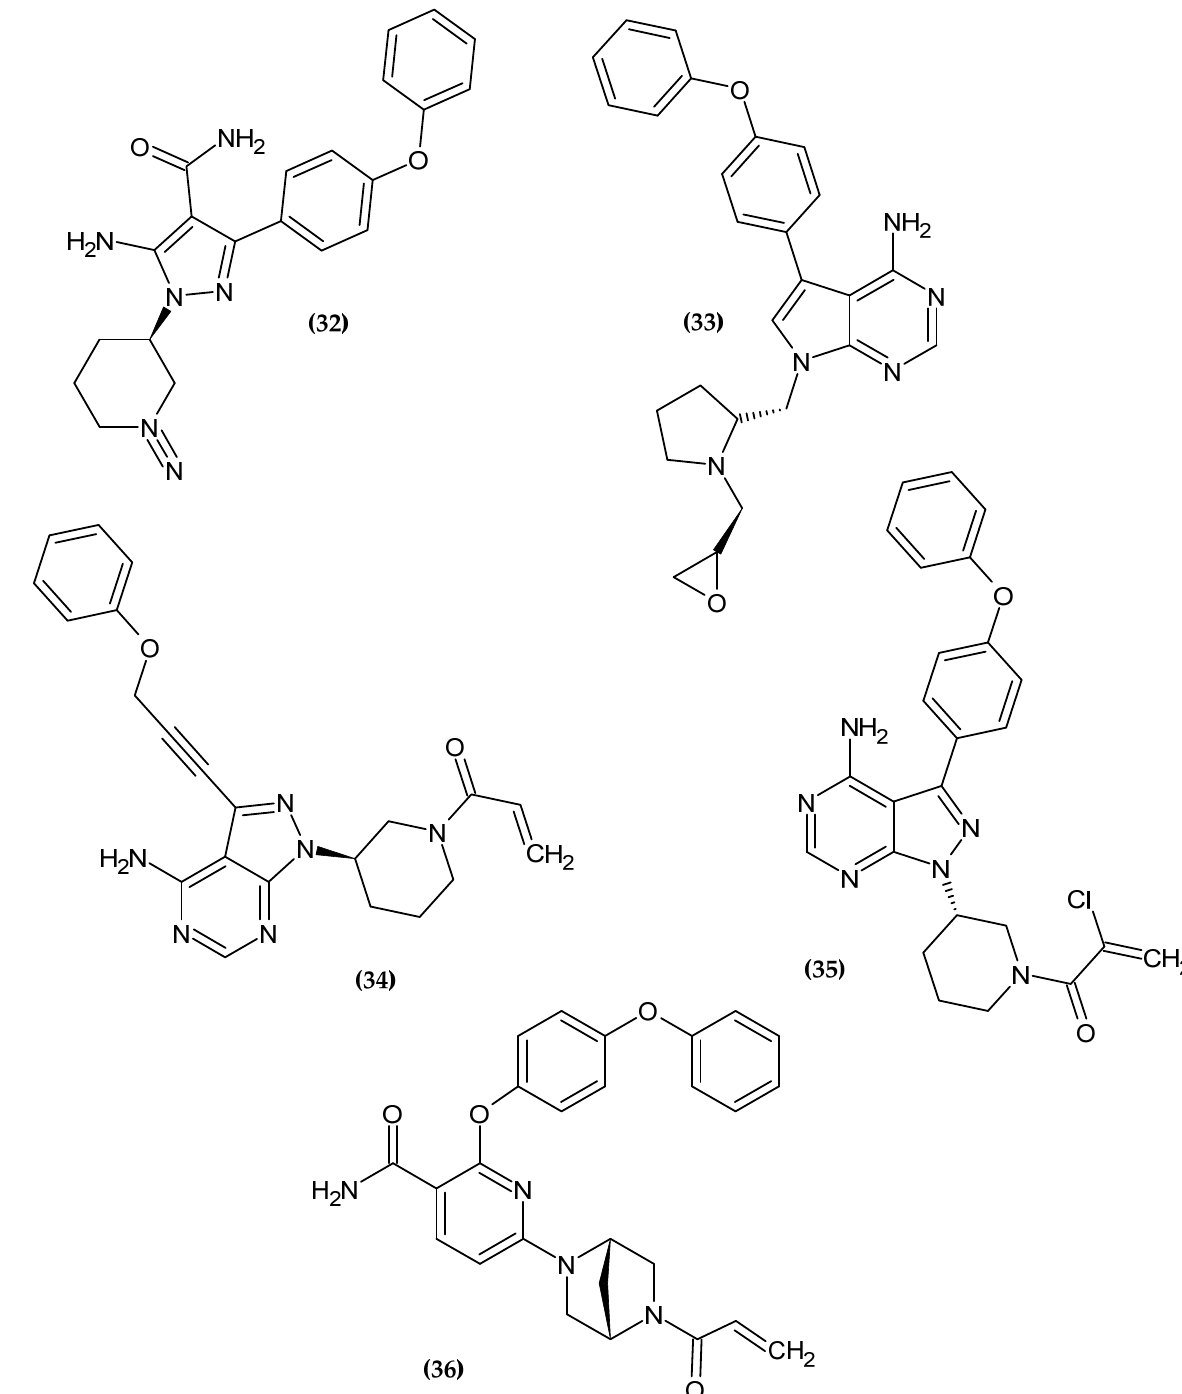
Figure 16. The novel potential BTK inhibitors bearing a phenoxy group.